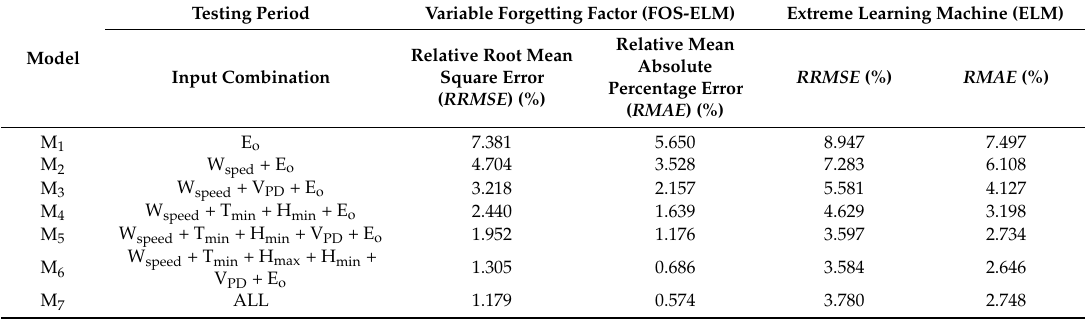
Table 3. Numerical comparison between FOS-ELM and ELM models based ( RRMSE , %) and the ( RMAE , %) computed within the test sites. Note that the best model is boldfaced. Testing Period Variable Forgetting Factor Model